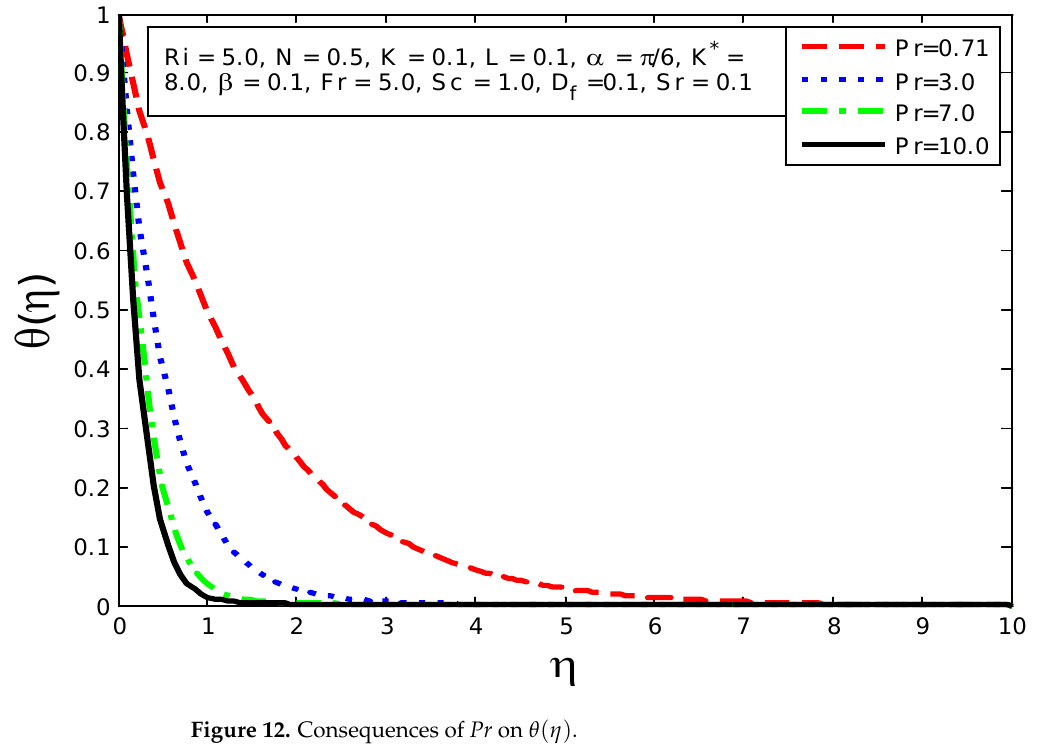
Figure 12. Consequences of Pr on